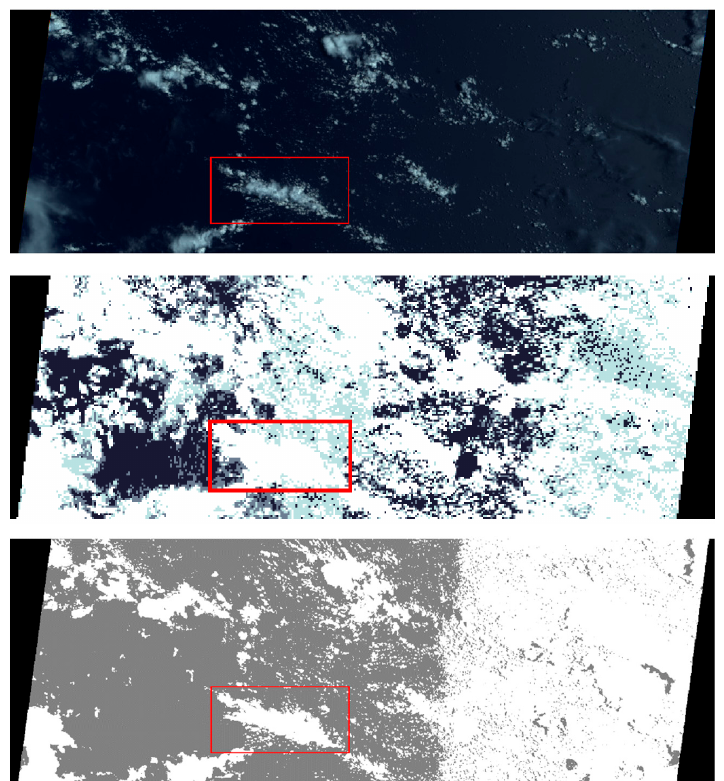
Figure 7. The red, green, and blue (RGB) image, the RCCM, and the custom cloud mask of Orbit 19726 Block 86, at the nadir view angle (AN). In the RCCM, the white indicates the high confidence cloud, the light green the low confidence cloud, the gray the low confidence clear, and the darker gray the high confidence clear. The black indicates no retrieval. The region selected for reconstruction is indicated in the red boxes. The widespread erroneous cloudiness on the right side of the cloud masks is due to sun